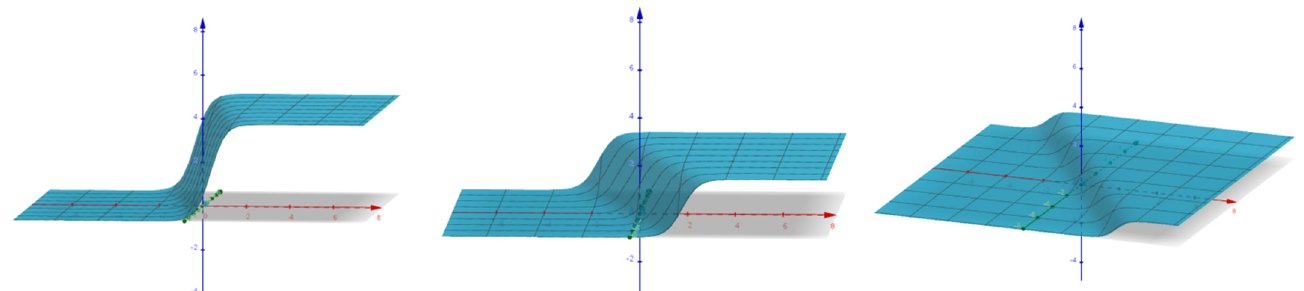
Figure 3. When n = 2, fix α = − 3 and take β as − 4.6, − 1 and − 0.3 respectively. For the travelling wave solutions of Equation (19), when n = 2, β = − 2, the corre- sponding graphs of α = − 5, − 1.5 and − 0.3 are given as follows (Figure 4):